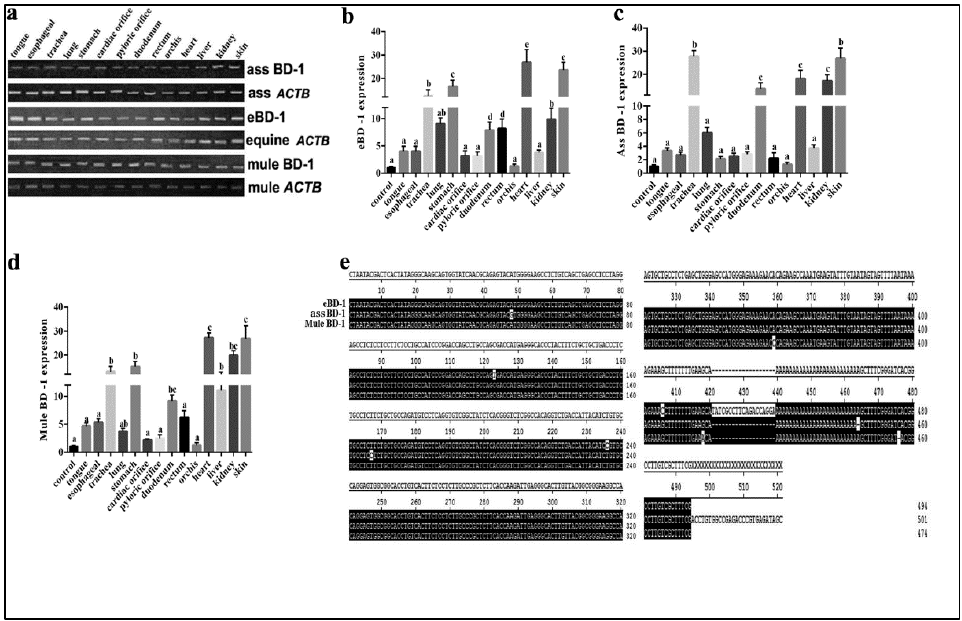
Figure 1. BD-1 expression in different tissues collected from horse, ass, and mule. ( a ) PCR-detected BD-1 expression in tongue, esophagus, trachea, lung, stomach, cardiac orifice, pyloric orifice, rectum, orchis, kidney, and skin. β -actin (ACTB) was used as the reference housekeeping gene. qPCR was used to measure different concentrations in various tissue, ( b ) eBD-1 , ( c ) ass BD-1 , ( d ) mule BD-1 . ( e ) RACE PCR sequencing homology results. The analysis of sequence homology used MEGA-6 following the methods of Tamura K et al. [29]. Significant differences among results were determined using one-way ANOVA, followed by Dunnett’s test to control the comparison number ( n = 3). Data are presented as means ± SD. Different letters indicate significantly different means at p < 0.05. 3.2. The ELP-(V) 30 -OEBD-1 Recombination Protein Is Highly Expressed after Two Inverse Transition Cycling (ITC) Here, we first confirmed the sequence of ELP-(V) 30 -OEBD-1 (for short OEBD-1) at 528bp. Similar to Shamji et al., we observed that the ELP-(V) 30 is highly expressed at 32 °C [25]. To determine the effect of ITC on OEBD-1 expression, we measured the levels of OEBD-1 after different ITC repetitions through Coomassie brilliant blue staining and western-blotting (WB). The OEBD-1 recombination protein was predicted to have a molecular weight of 19,360 Da. Protein bands were identified SDS-PAGE gel in 15 kDa~25 kDa by Coomassie brilliant blue stained (Figure 2a), and the WB results showed that the OEBD-1 recombination protein expression is higher after two ITCs than a single ITC (Figure 2). However, when we added more ITC, the OEBD-1 expression levels were weaker after three ITCs and eventually disappeared after four ITCs.